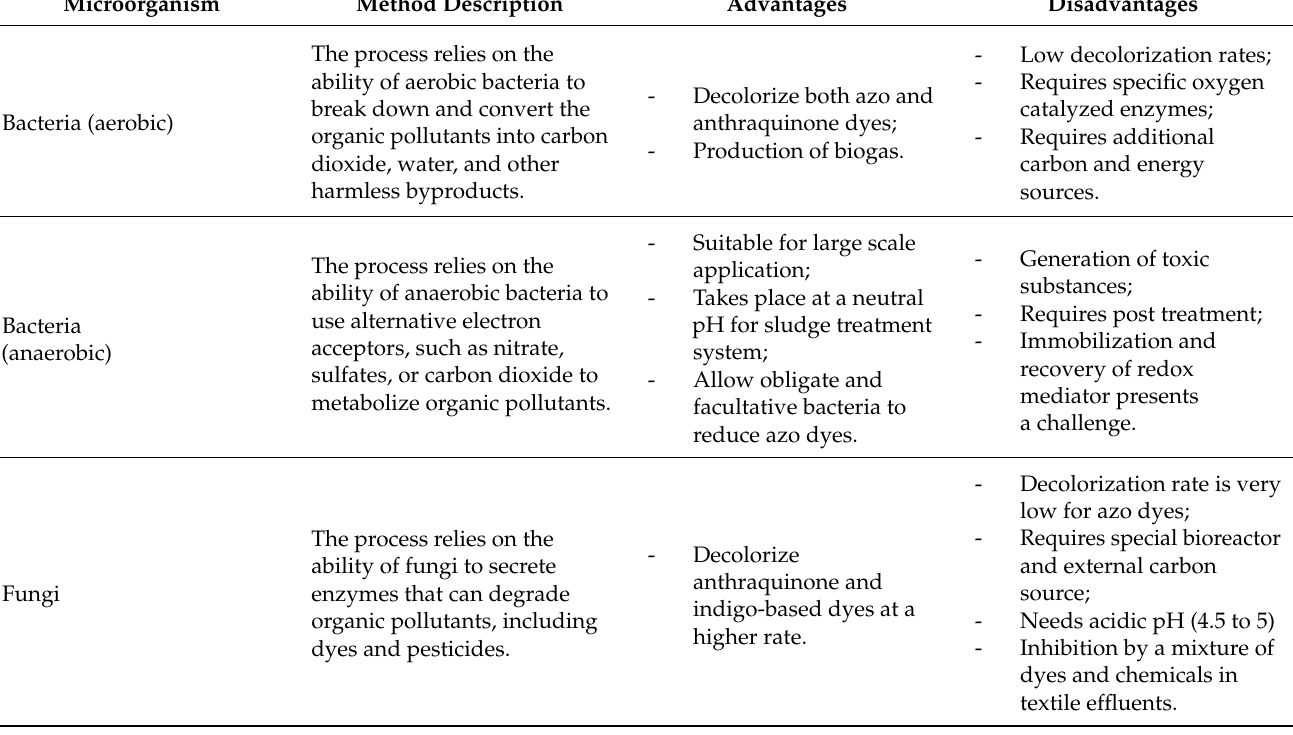
Table 8. Advantages and disadvantages of some of the microorganisms in the biological method of textile effluent